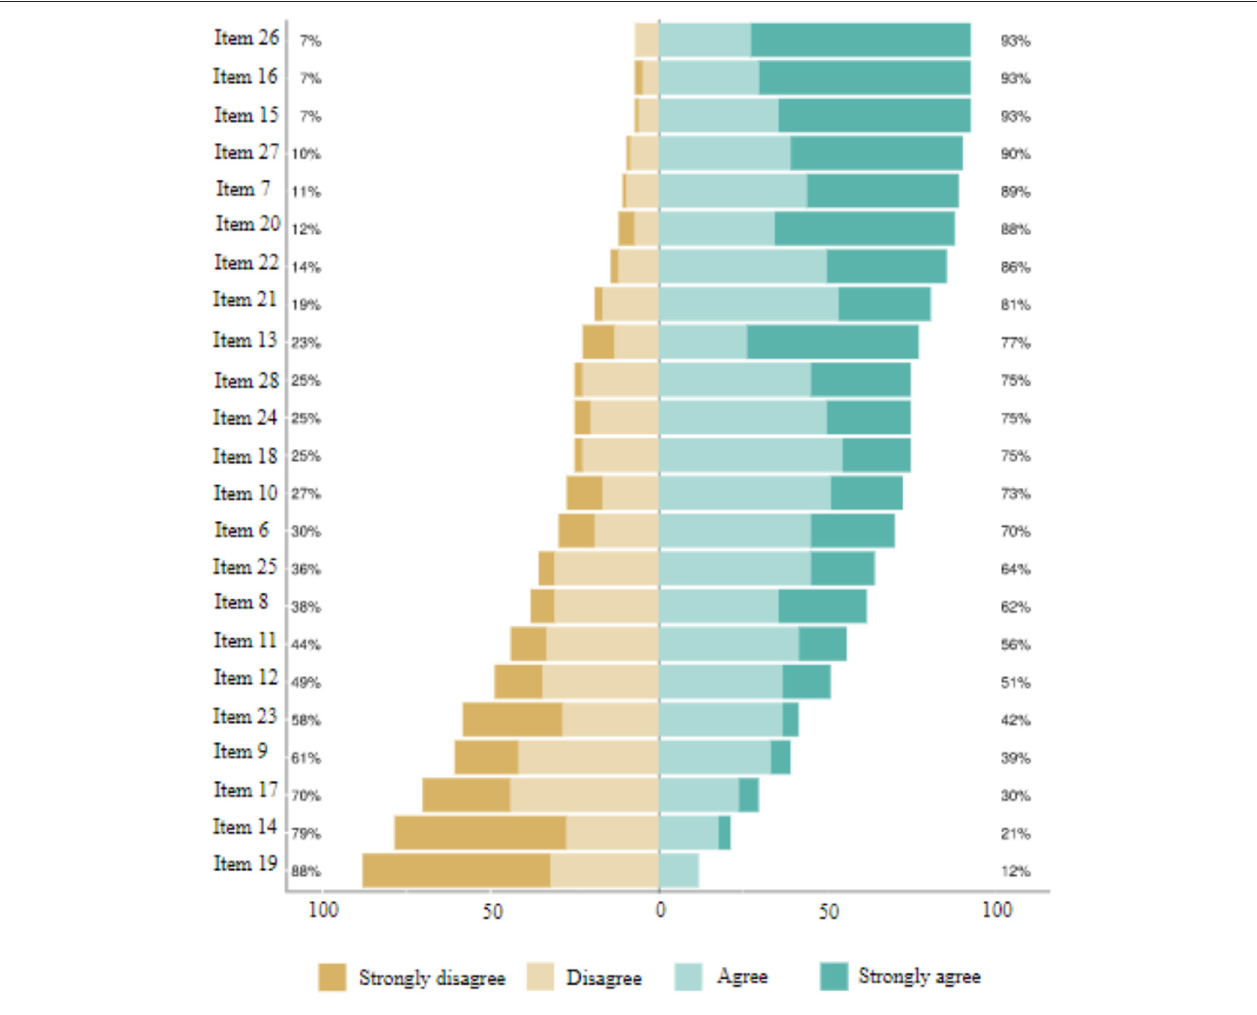
FIGURE 1 | Block 2. Teachers’ academic